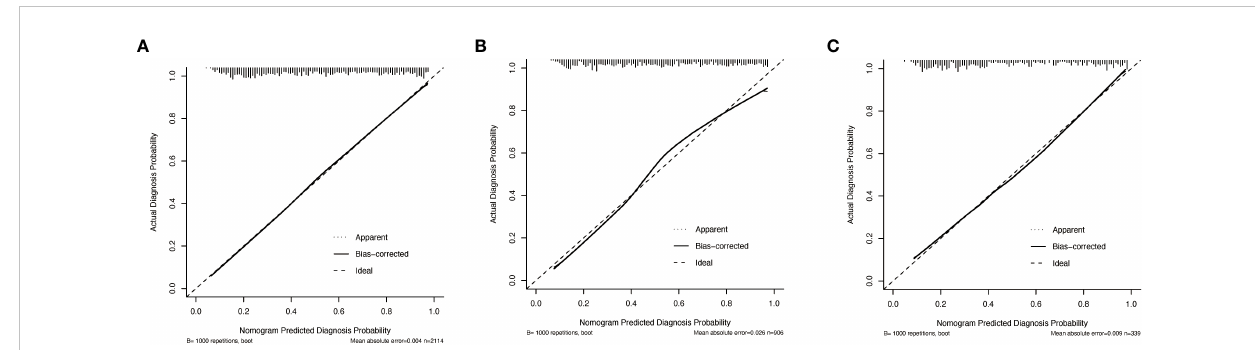
FIGURE 4 Calibration curves of the thyroid cancer lymph node metastasis nomogram, thyroid cancer lymph node metastasis AI system, clinical model and US- reported CLN status in PTC patients. (A) Calibration curves for predicting CLNM in the training cohort. (B) Calibration curves for predicting CLNM in the internal validation cohort. (C) Calibration curves for predicting CLNM in the external validation